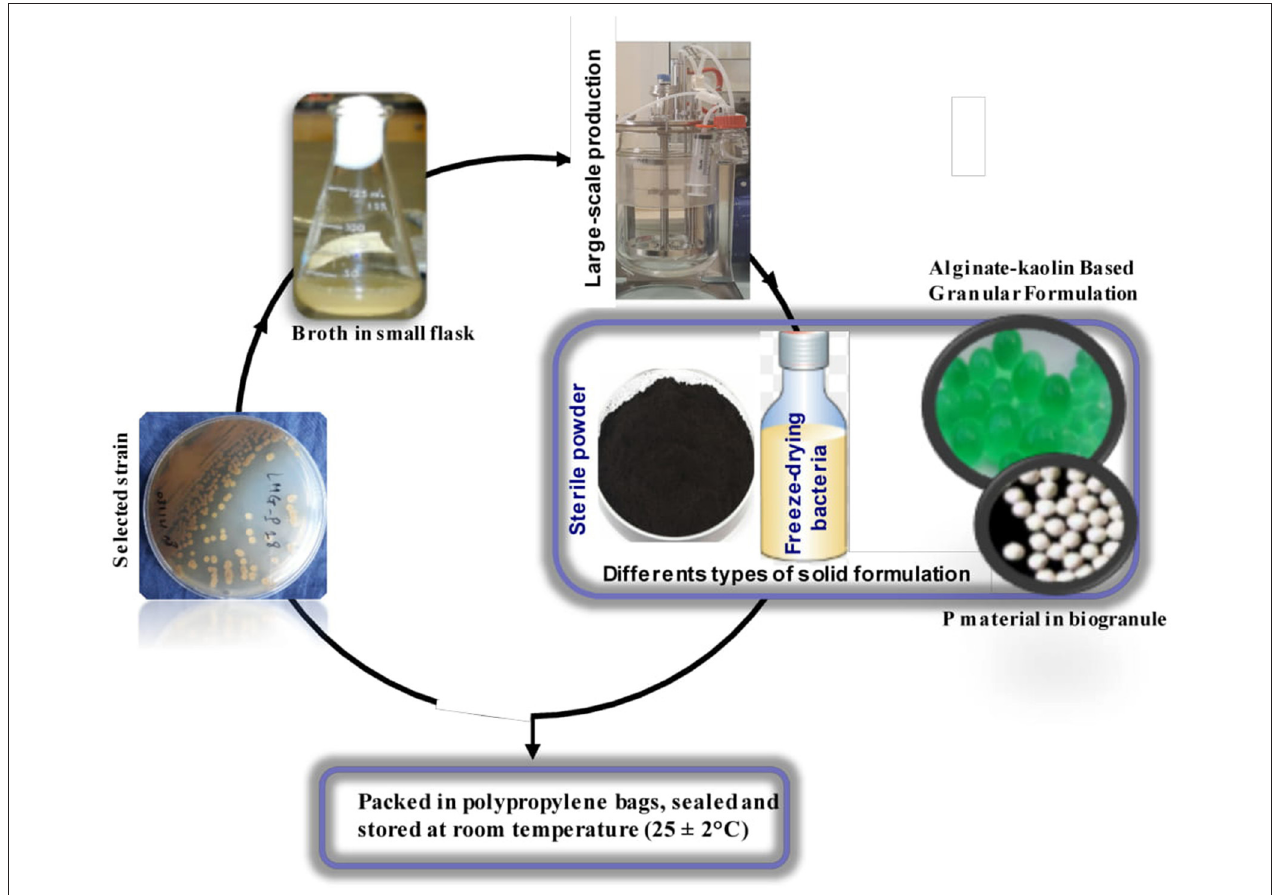
FIGURE 3 | Simplified schematic flow chart for the production of Actinobacteria biofertilizer. Quality control is done at all stages of production a production as previously described (II.3).